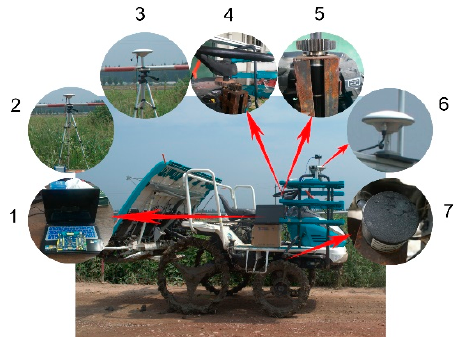
Figure 1. Automatic steering control experimental platform. ( 1 ) Navigation controller; ( 2 ) reference station; ( 3 ) base station antenna; ( 4 ) automatic steering system; ( 5 ) steering servo motor; ( 6 ) antenna of the movable station; ( 7 ) steering angle sensor of the front wheel.